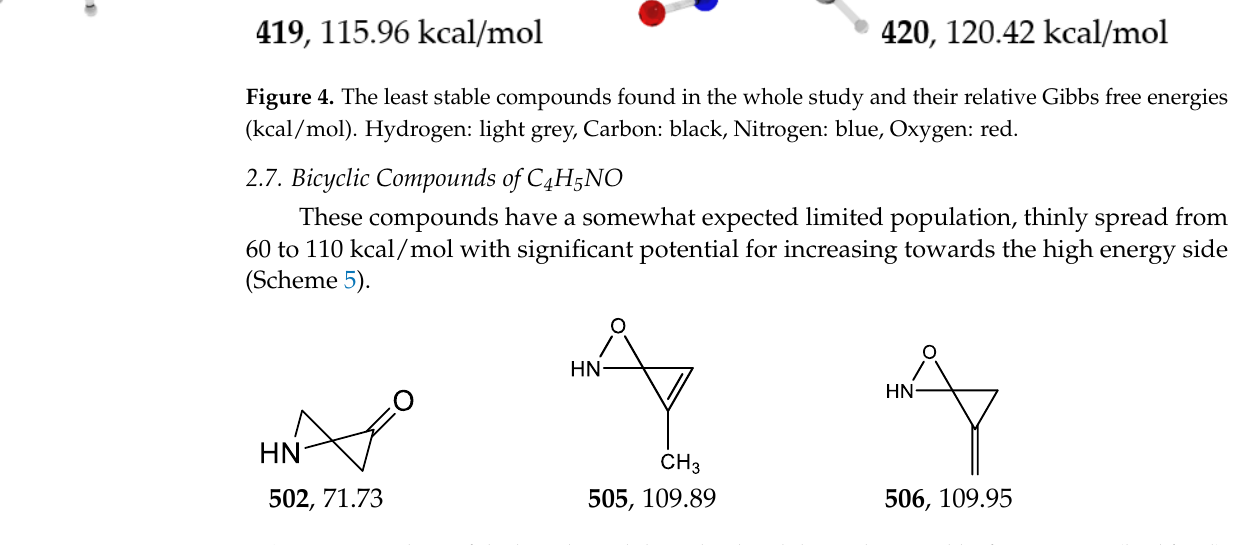
Scheme 5. Members of the bicyclic Stability Island and their relative Gibbs free energies (kcal/mol).